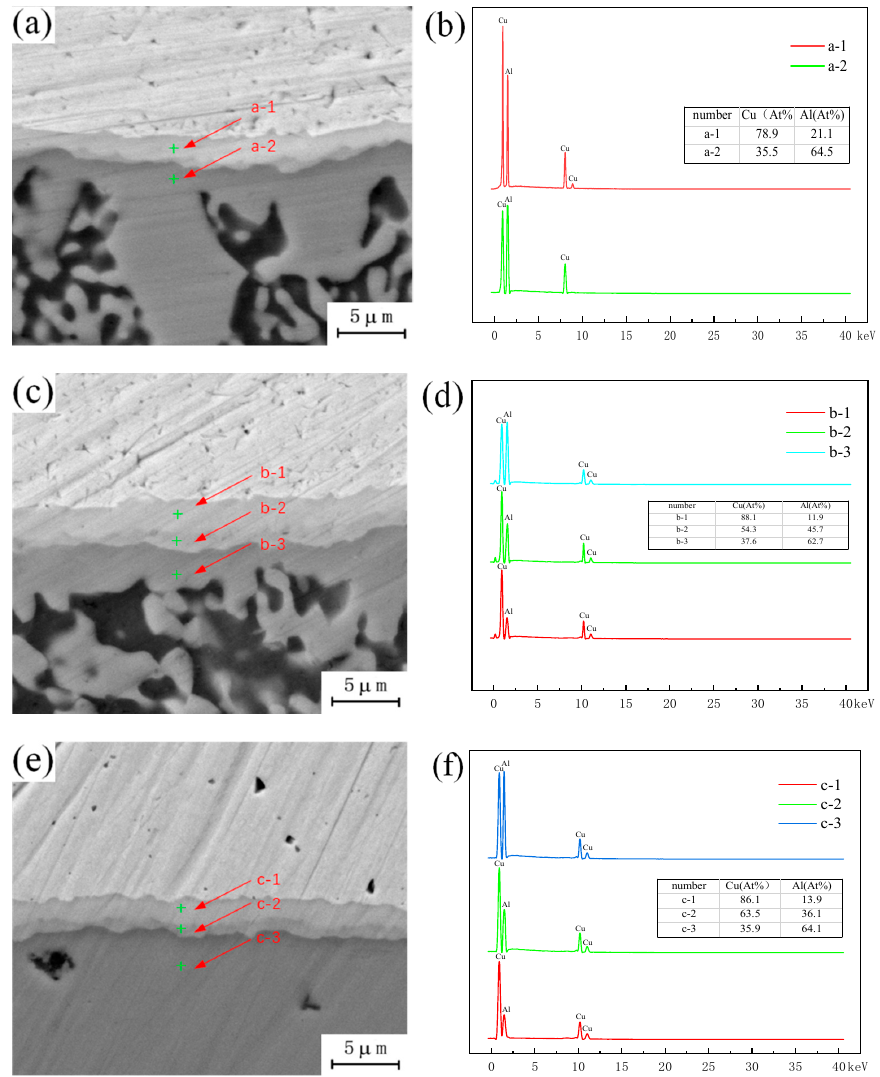
Figure 9. Microstructure of intermetallic compound (IMC) layer under different annealing conditions: ( a ) Annealing temperature 300 °C; ( b ) Content of copper and aluminum in a; ( c ) Annealing temperature 350 °C; ( d ) Content of copper and aluminum in b; ( e ) Annealing temperature 400 °C; ( f ) Content of copper and aluminum in c.